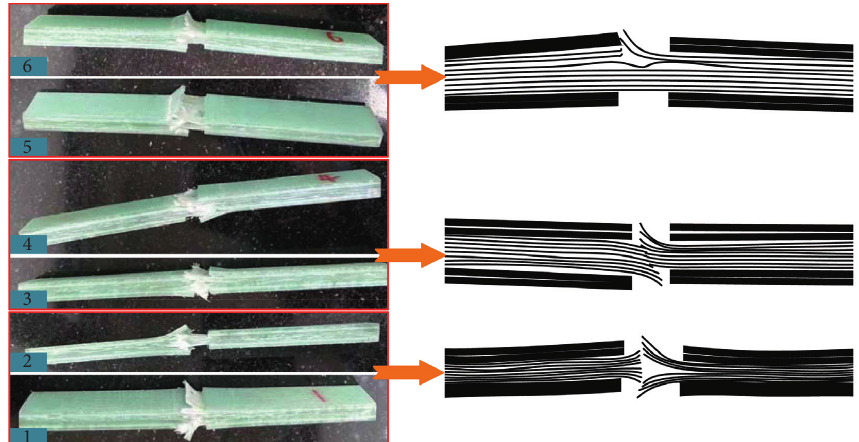
Figure 11: Details of fracture.